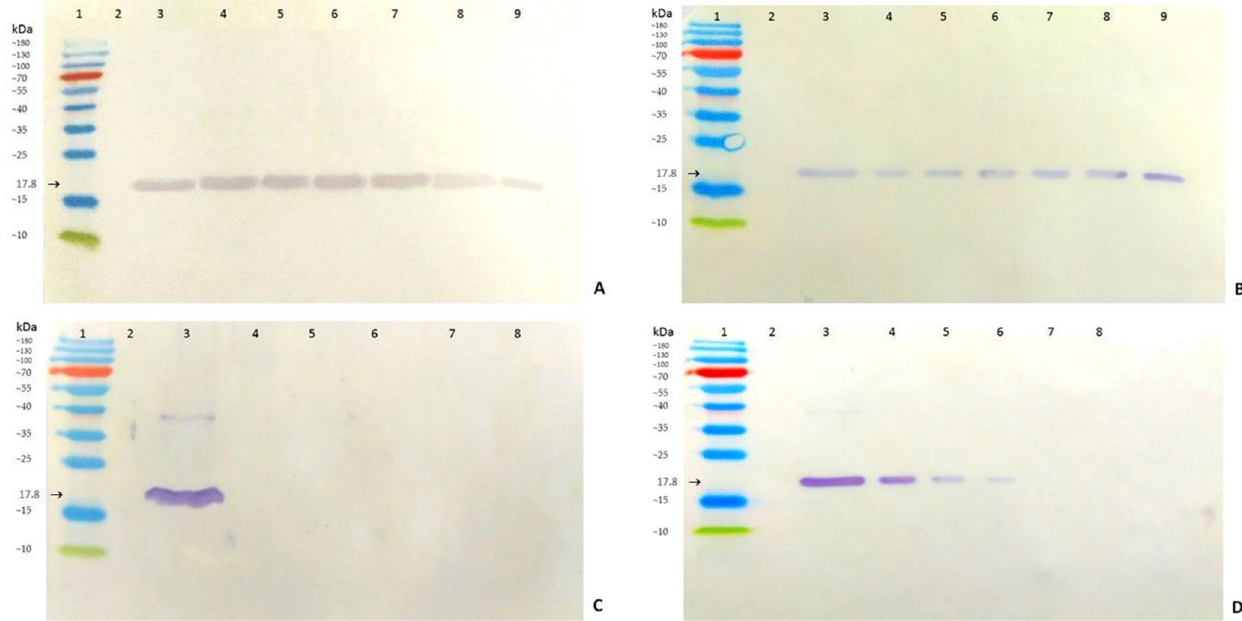
Figure 8. Persistence and resilience of ToMV in soil rhizosphere and root residues analyzed by Western immunoblots 24 months after the removal of the infected tomato plants from the soil. ( A )—rhizosphere sample, ( B )—root residues. Lanes: 1—protein ladder, 2—negative control, 3—positive